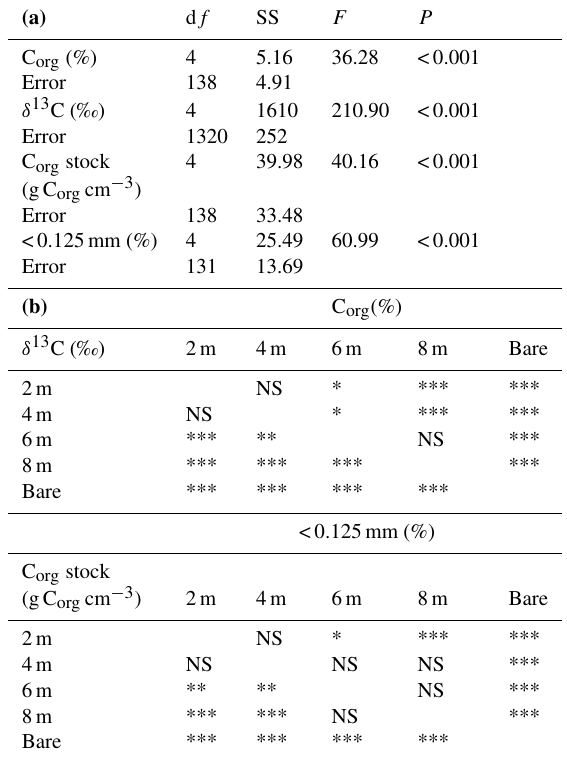
Table 2. (a) Results of one-way ANOVA on soil properties (normal- ized for ca. 500-year-old deposits). P values correspond with those provided by the f test. (b) Results of statistical testing (Tukey’s HSD) for significant effects of water depth on the physicochemi- cal parameters in the cores. Levels of significance are as follows: